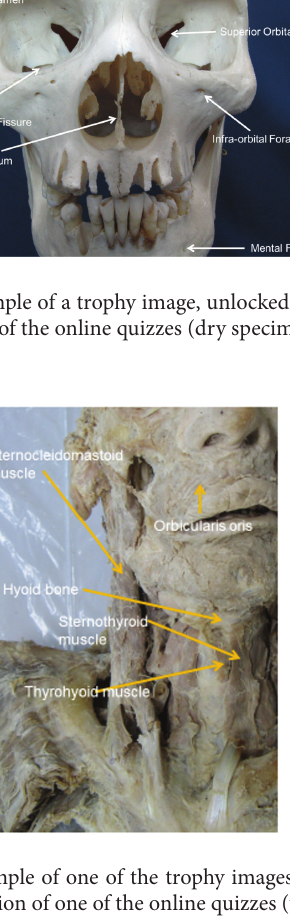
Table2:Showingstudentenrolment,averageage,andSECresponse rates in the head and neck anatomy course for the period of 2010– 2015, the duration of the